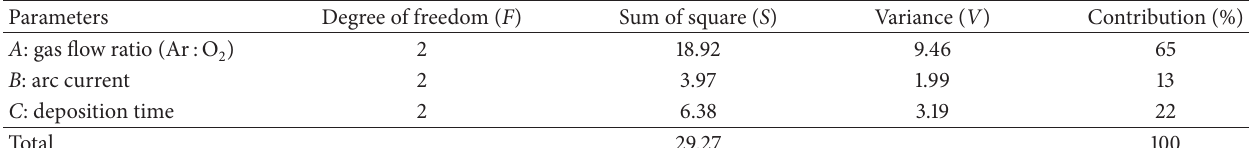
Table 7: ANOVA results of grey-relational grade for ZnO thin